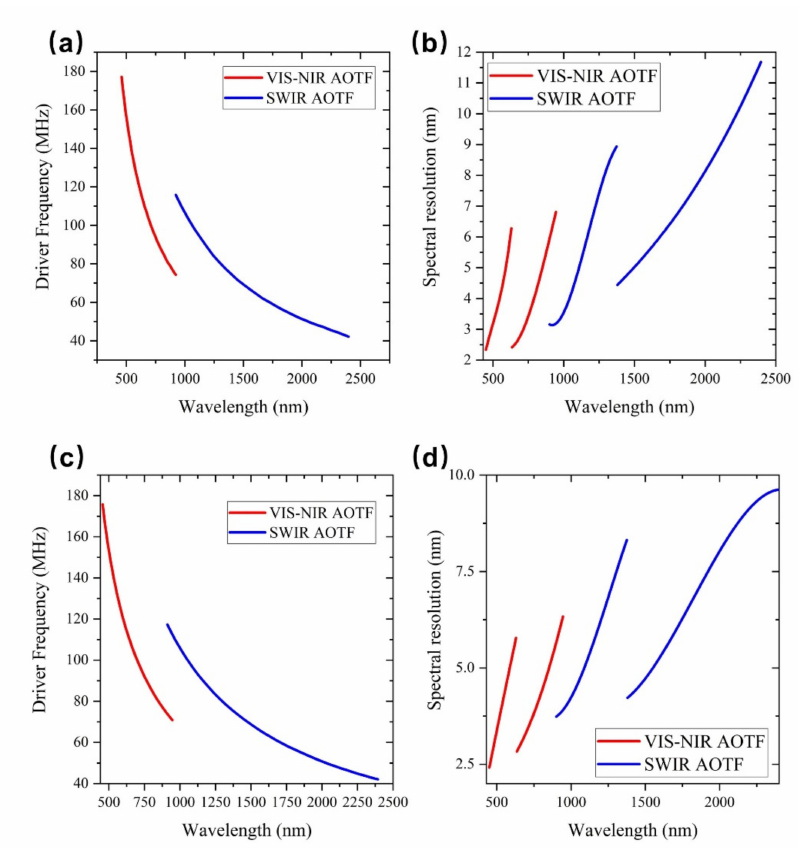
Figure 4. Driving frequency tuning curves of the acousto-optic tunable filters of the visible and near infrared imaging spectrometers onboard the Chang’e-3 ( a ) and Chang’e-4 ( c ); spectral resolution of the acousto-optic tunable filters vs wavelength for the Chang’e-3 ( b ) and Chang’e-4 ( d ) VNIS spectrometers.